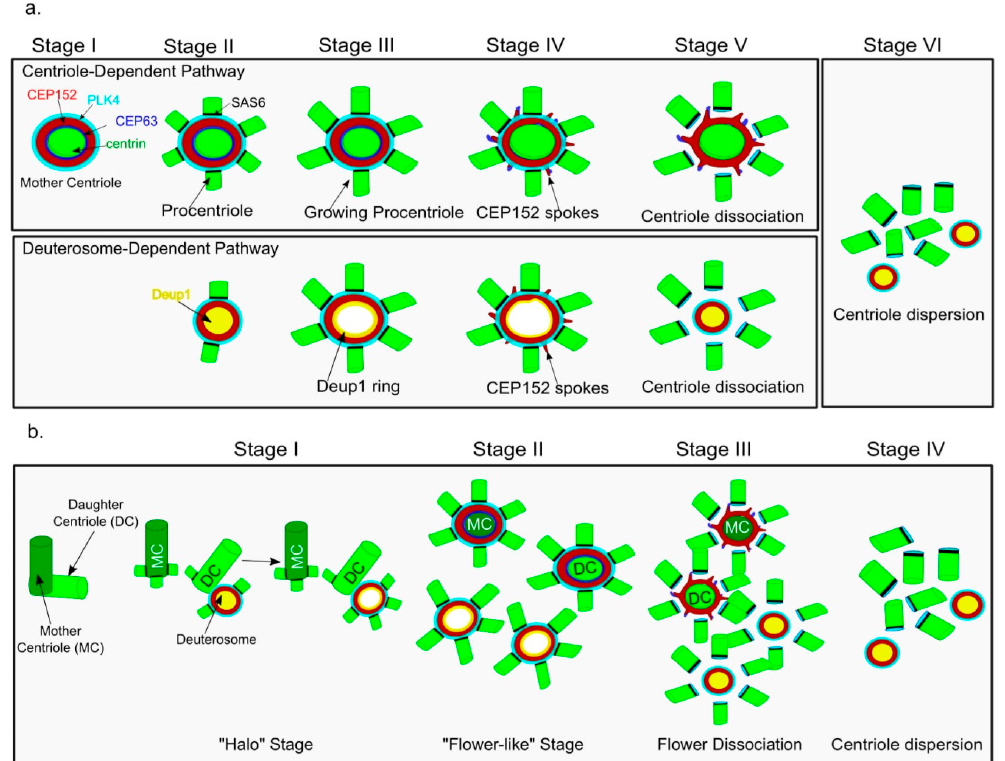
Figure 2. Comparison of the early stages of centriole amplification in MCCs as reported by ( a ) Zhao et al., 2013 and ( b ) Al Jord et al., 2014. The figure is adapted and modified from their respective papers for simplicity. Procentrioles are visible using Centrin as a marker. The stage I reported in Al Jord et al. corresponds to the stages II and III reported by Zhao et al., 2013 where procentrioles decorate deuterosomes, which are organized adjacent to the pre-existing daughter centriole (reported by Al Jord et al., 2014). Note that the localization of Deup1 is reported to change from being observed as foci inside the CEP152 ring to attaining a ring-like structure itself. In the later stages, procentrioles mature on their respective template-either the pre-existing centriole or deuterosome, to assume a flower-like arrangement. Subsequently, they are dispersed in the cytoplasm, only to reach at the apical side of membrane, generating ciliary